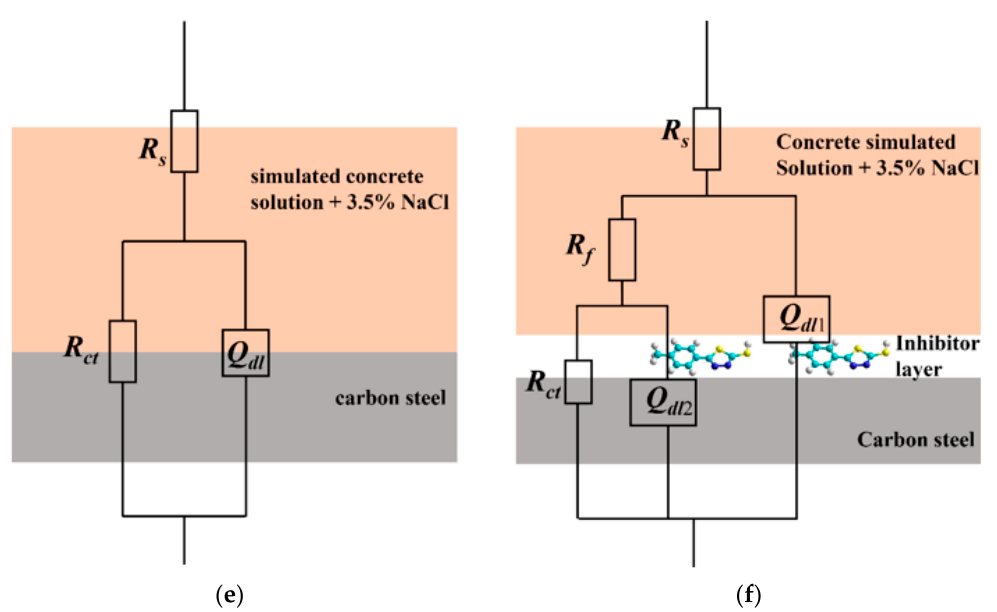
Figure 2. EIS spectra of Q235 carbon steel in simulated concrete solution with 3.5% NaCl in the absence of and with varied inhibitor concentrations: ( a ) Nyquist plots; Bode plots of ( b ) blank sample, 0.1 and 0.5 mmol/L, ( c ) of 2.0 and 5.0 mmol/L, and ( d ) of | Z |; equivalent circuit with ( e ) one-time constant and ( f ) two-time constants.